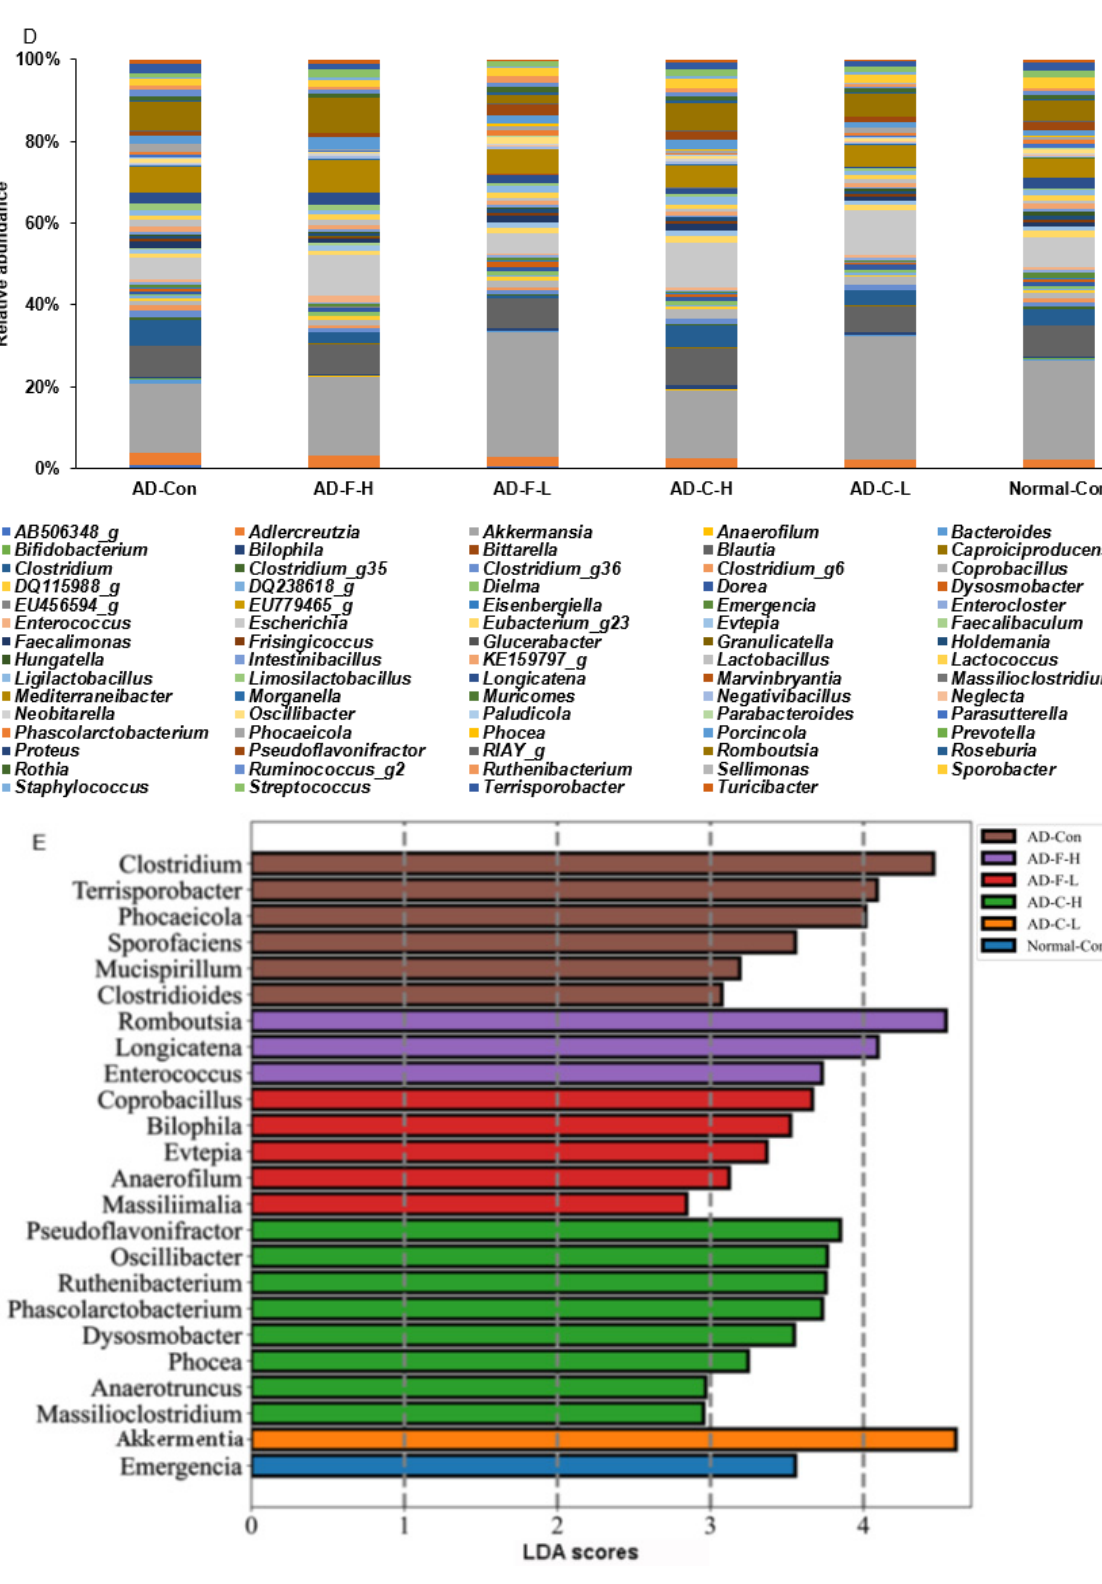
Figure 5. Gut microbiota community. ( A ) α -diversity. ( B ) β -diversity. ( C ) Relative abundance of cecum bacteria at the family level. ( D ) Relative abundance of cecum bacteria at the genus level. ( E ) LDA scores of specific bacteria among the groups in Lefse analysis. The bars and error bars represent the means ± standard deviations ( n = 4). Hippocampal amyloid- β (25–35)-infused rats